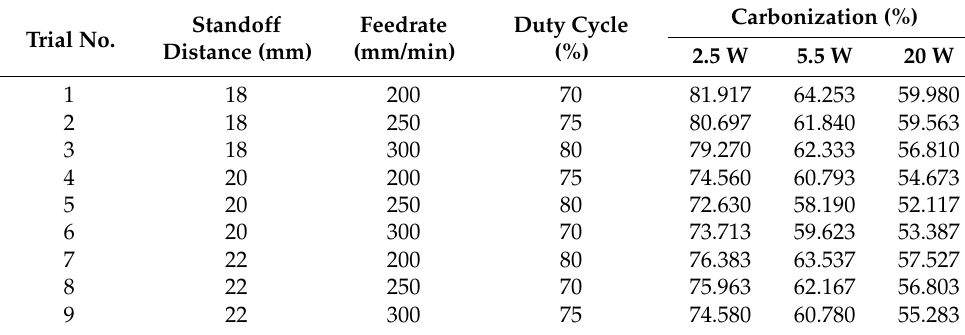
Table 1. Effect of diode laser on Table 1. E ff ect of diode laser on carbonization.